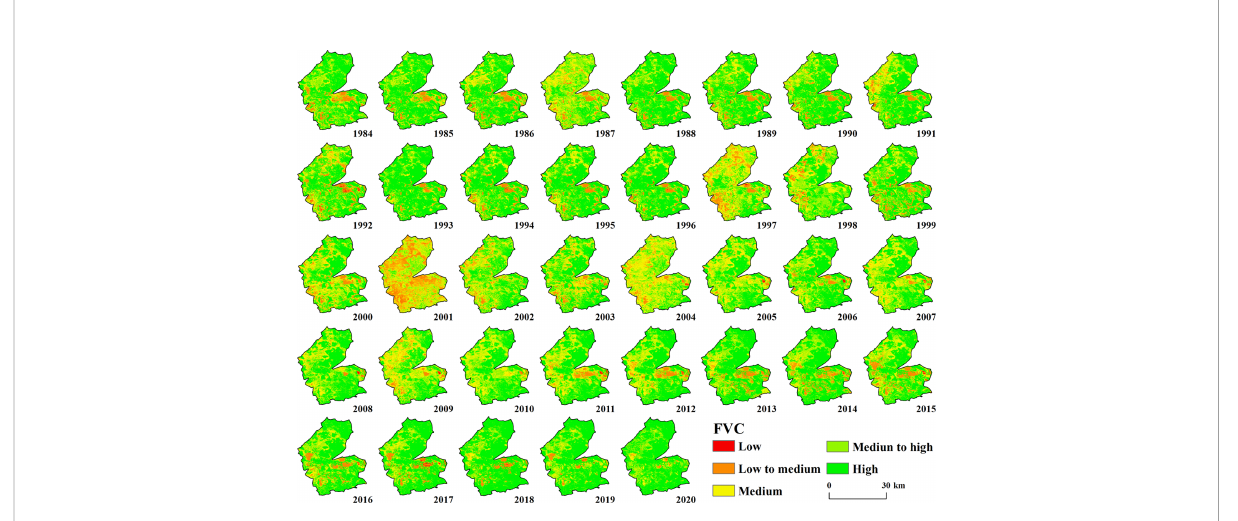
FIGURE 2 Spatial distribution characteristics of FVC in the study area from 1984 –